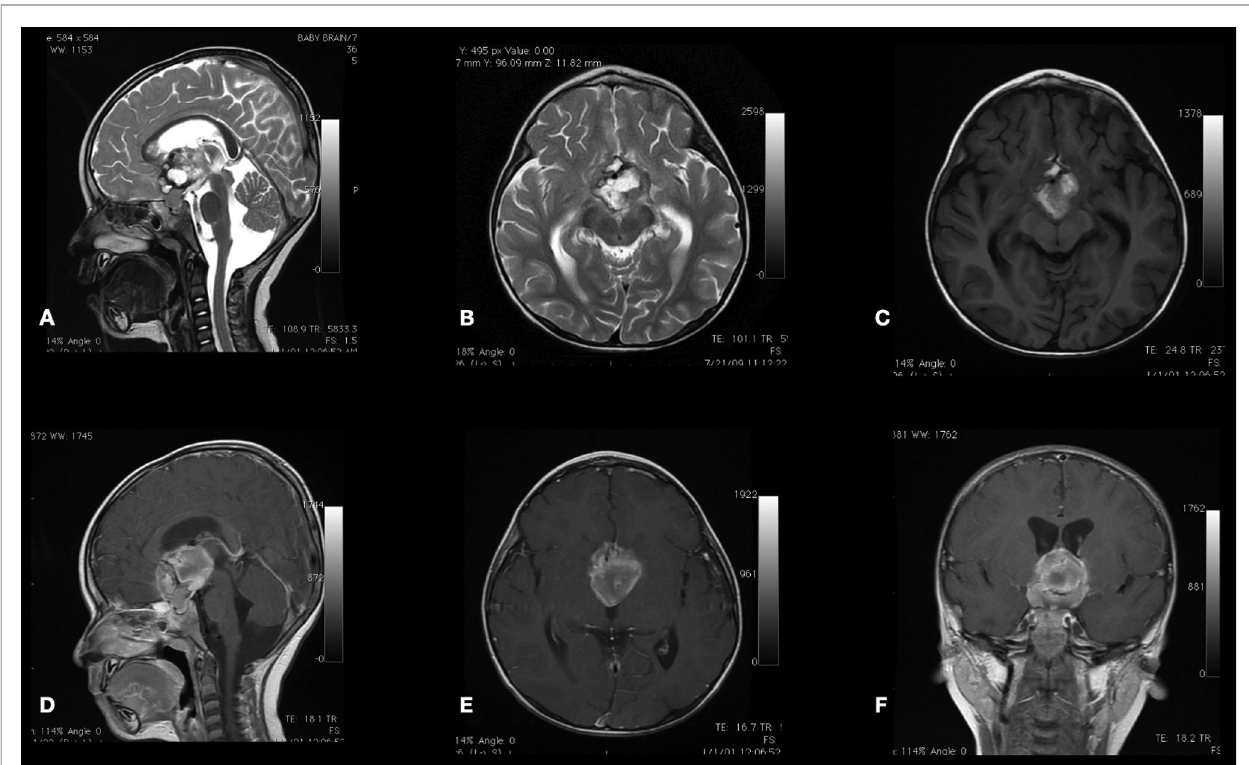
FIGURE 2 | Sagittal ( A ) and axial ( B ) T2-WI and axial ( C ) T1-WI MRI scan sequences of the brain reveal large sellar and suprasellar cystic and solid lesions containing subacute components of blood products. The lesion is enhanced heterogeneously following intravenous contrast administration ( D – F ).